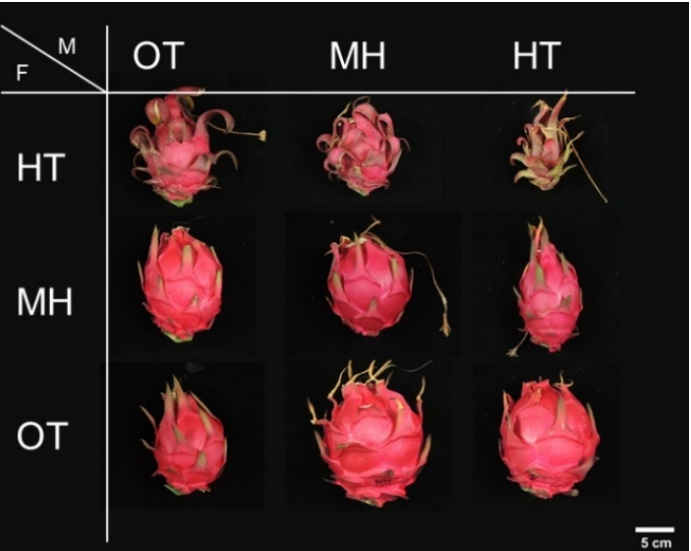
Figure 2. Fruit characteristics after self-pollination or mutual cross combinations by control (OT, 30